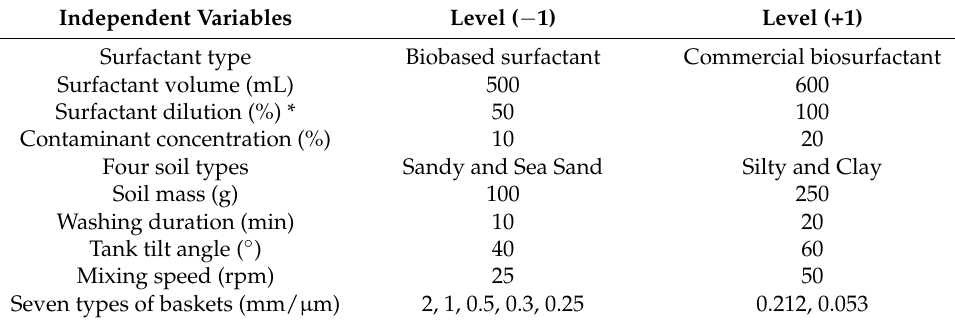
Table 1. Variables and levels initially considered in the